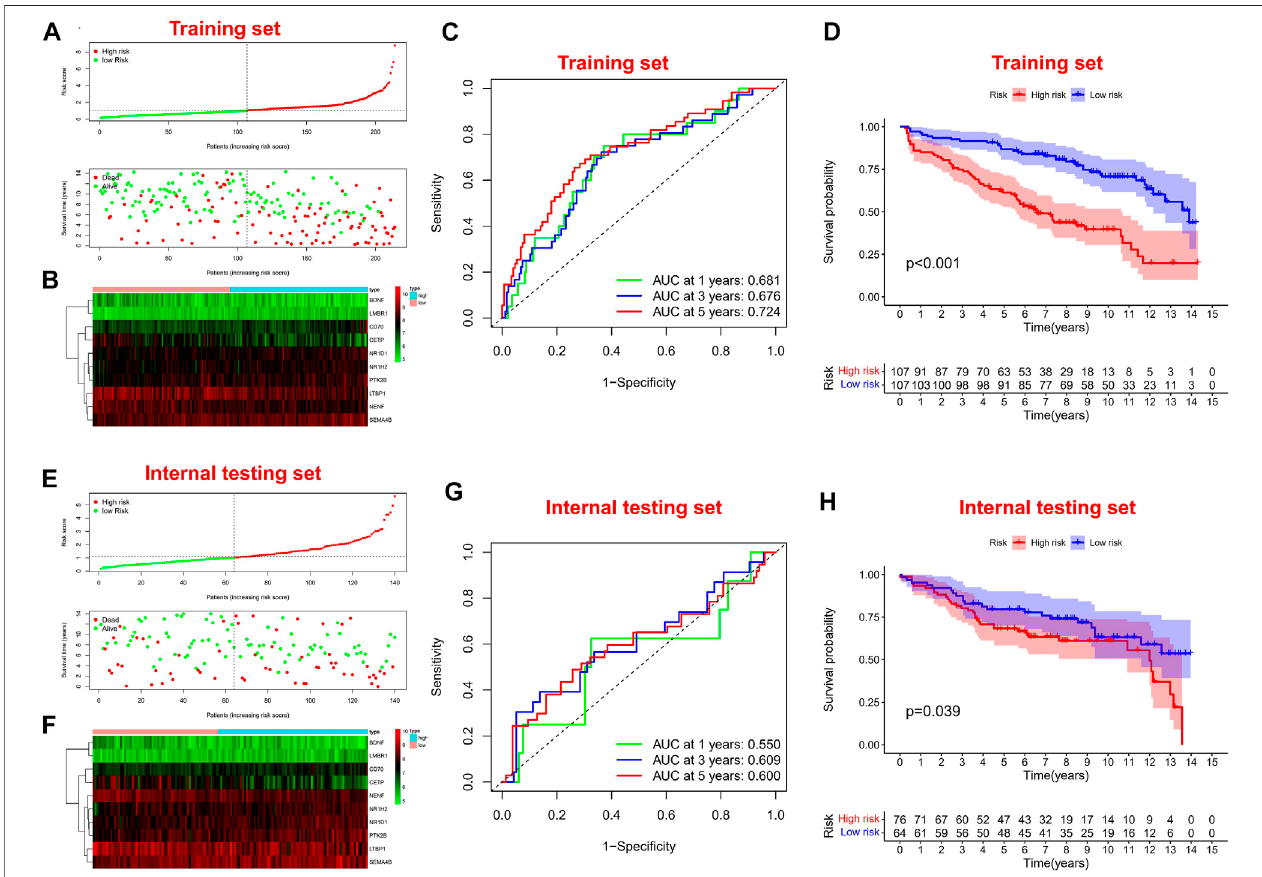
FIGURE5| Survivalprognosticprediction totest theprognosticmodel. (A, B) Distribution ofriskscores,survivalstatus and correspondinggeneexpression levels of patients in the training set. (C) ROC analysis about one, three, and fi ve-year survival prediction in the training set. (D) Kaplan – Meier analysis in the training set. (E, F) Distributionofriskscores,survivalstatusandcorrespondinggeneexpressionlevelsofpatientsintheinternaltestingset. (G) ROCanalysisaboutone,three,and fi ve-year survival prediction in the internal testing set. (H) Kaplan – Meier analysis in the internal testing